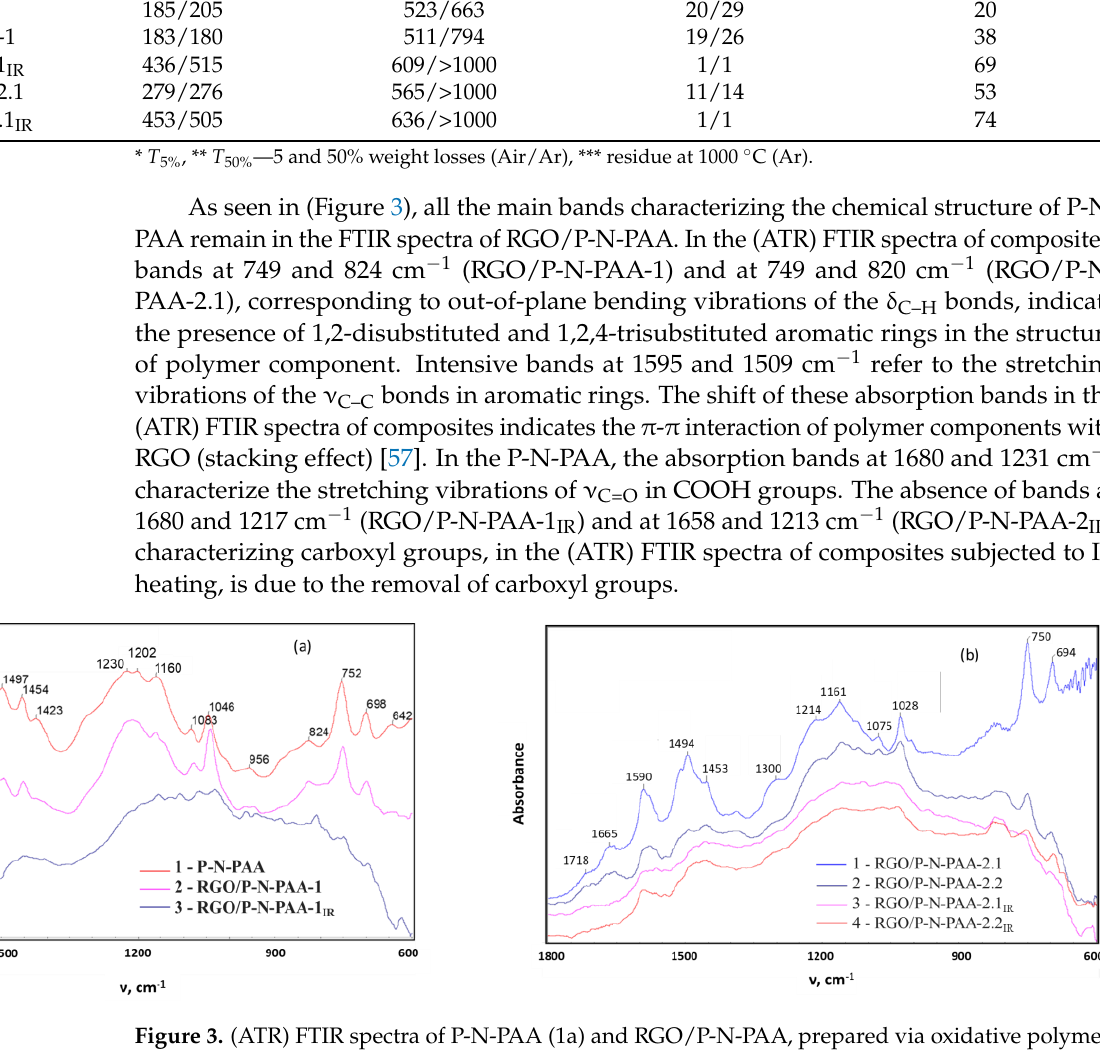
Figure 3. (ATR) FTIR spectra of P-N-PAA (1a) and RGO/P-N-PAA, prepared via oxidative polymer- ization ( a ) and from a solution ( b ).